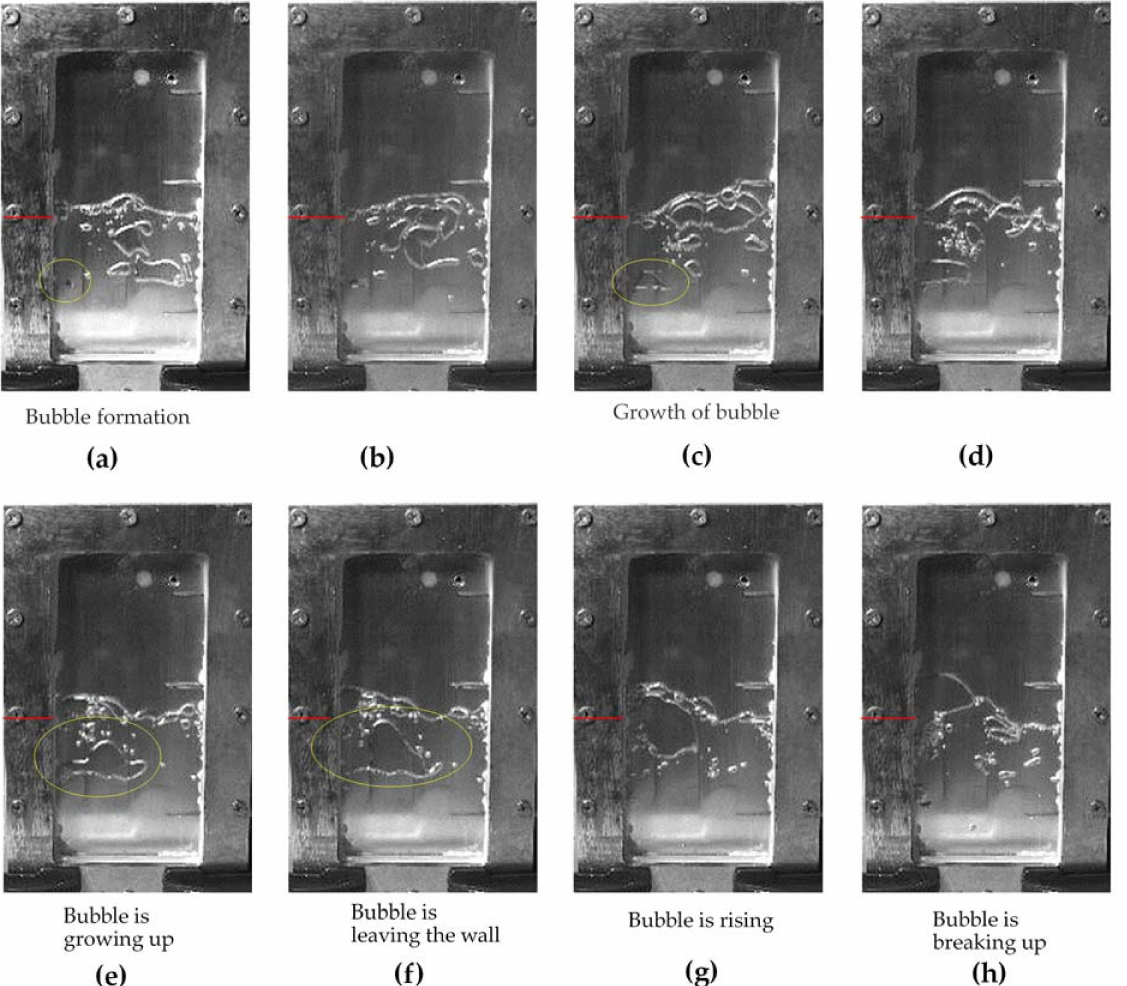
Figure 16. Time-series diagram of heterogeneous nucleation and bubble growth in the evaporation section of the PGHP (FR = 48%, Q in = 80 W, ∆ t = 60 ms). Note: the initial level is shown as the red line, ( a ) bubble behavior at 0 ms; ( b ) 60 ms; ( c ) 120 ms; ( d ) 180 ms; ( e ) 240 ms; ( f ) 300 ms; ( g ) 360 ms; ( h ) 420